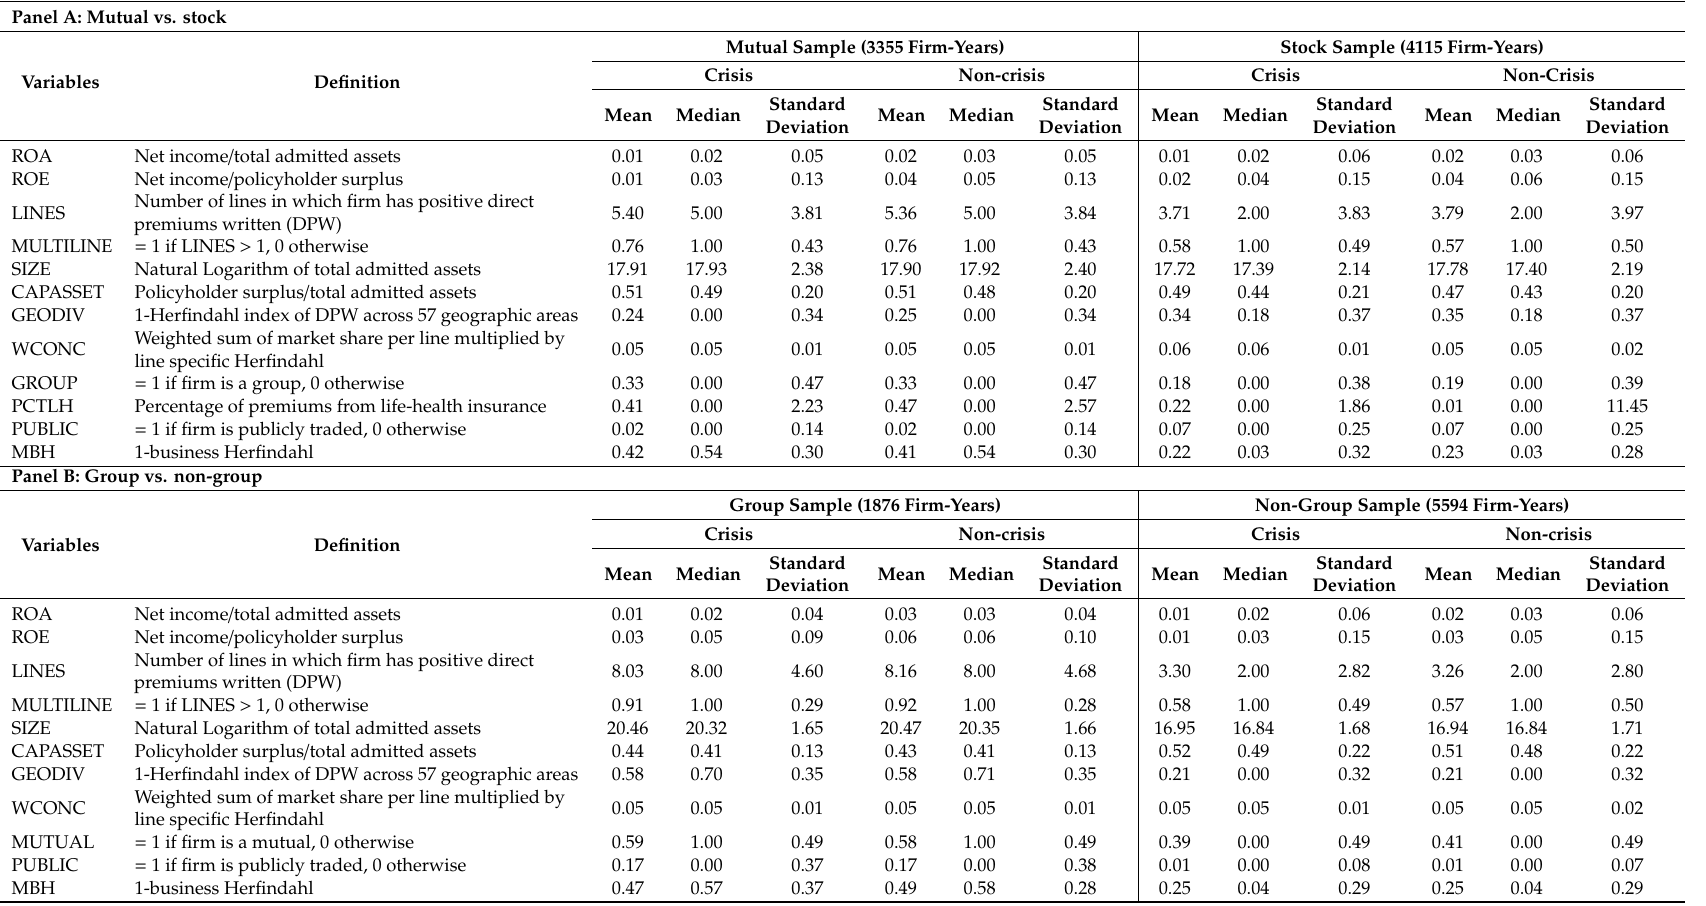
Table 2. Sample descriptive Statistics